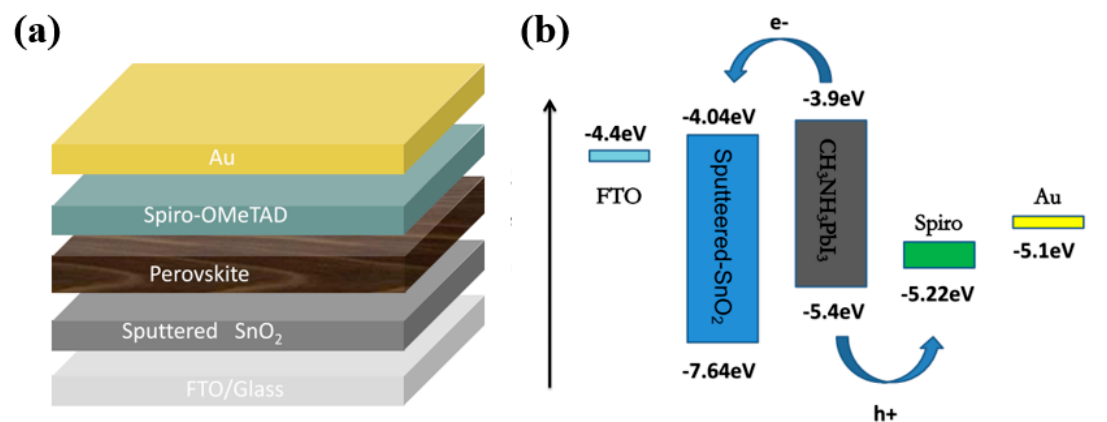
Figure 1. ( a ) Structure diagram and ( b ) band diagram of the device.